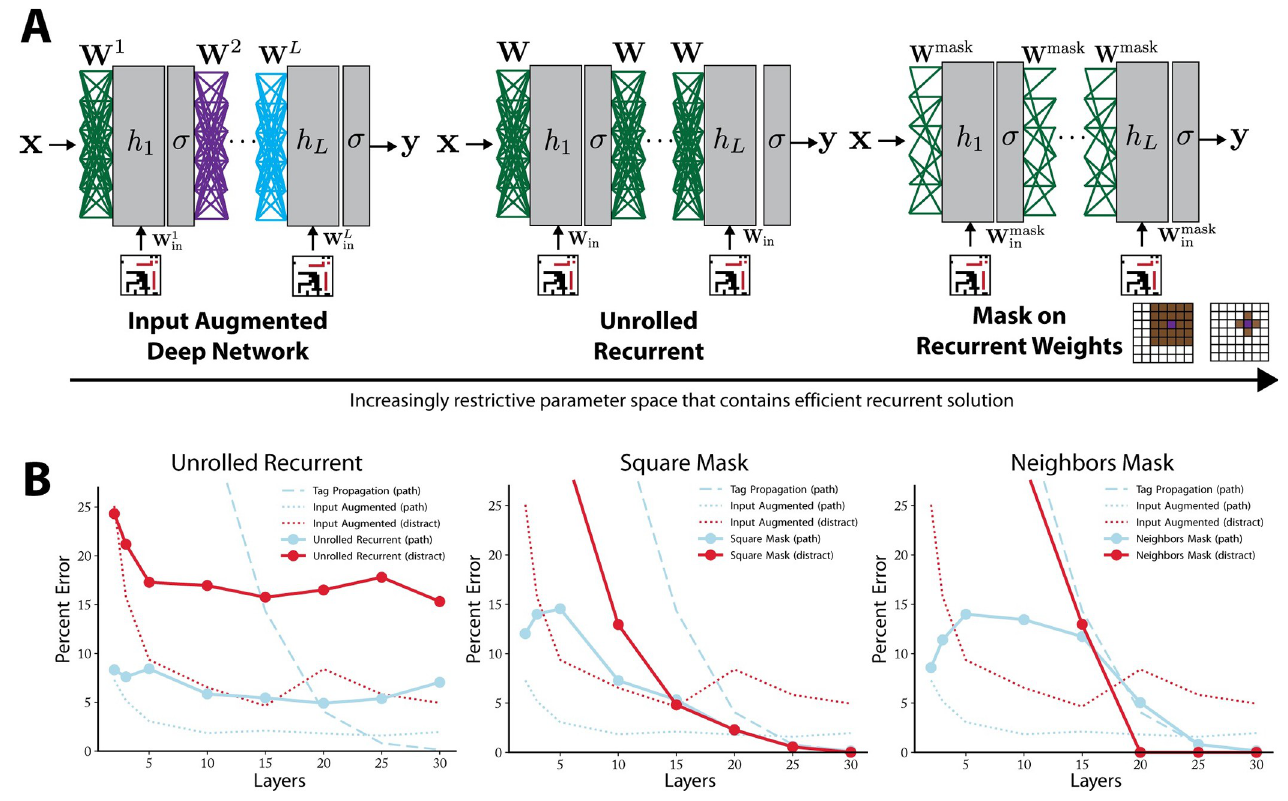
Fig 3. Masked recurrent networks performance on the edge-connected pixel task. (A) Schematic of the addition of constraints on the feedforward parameter space generating an increasingly restrictive parameter space that still contains the efficient tag-propagation solution. From left to right: weight sharing across the layers creates an unrolled recurrent network, masking of shared weights (i.e., enforcing locality in the operations) to a grid around each pixel creating unrolled recurrent networks with sparse weights (middle), masking to just the nearest neighbor of each pixel (right). (B) Decomposition of error by pixel type for each model. X-axis corresponds to number of layers in the network. Blue dots and line correspond to errors on path pixels, red dots and line correspond to errors on distractor pixels. Dashed line corresponds to tag propagation error on path pixels for reference. Dotted blue and red lines indicate input augmented architecture error on path (blue) and distractor pixels (red). Each subpanel corresponds to a different network architecture. From left to right: unrolled recurrent, square mask, neighbors only mask.